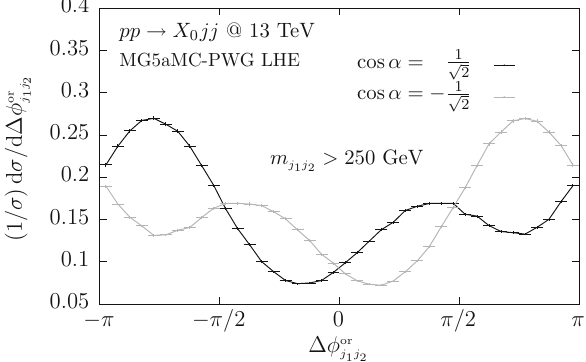
Fig. 9 Normalised differential cross section as a function of the ori- ented azimuthal separation of the two leading jets, defined in Eq. (3.12), for the two mixed CP scenarios with cos α = 1 / √ cos α = − 1 / 2 (grey curve). A cut of 250 GeV is imposed on the dijet